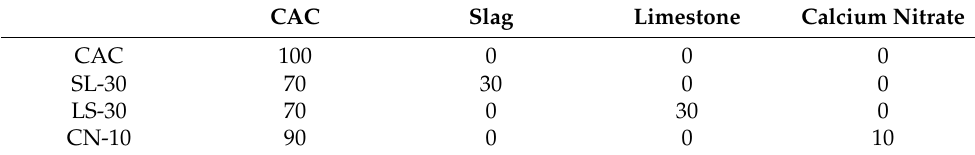
Table 5. Mix proportion of the pastes used for the mortar-reinforcement specimen (wt.%).